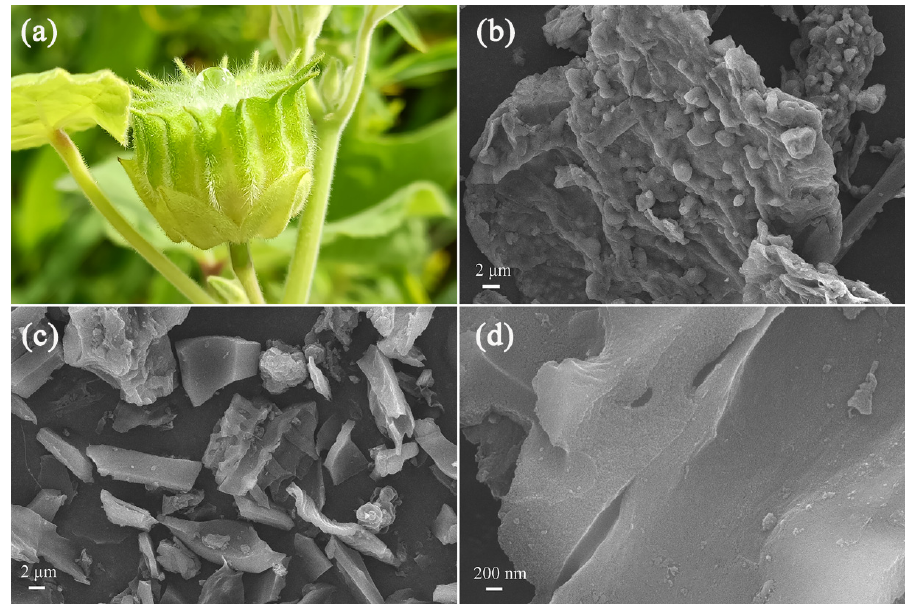
Figure 3. ( a ) The photograph of AC; the SEM images of ( b ) AC fragments and ( c , d ) PCAC. The results of the elemental analysis showed that the mass fractions of C, H, N, S, and O elements in PCAC were 86.04, 0.69, 0.17, 0.00, and 6.59, respectively. This indicates that the main component of PCAC was carbon. In the Raman pattern of PCAC (Figure 4a), there are two characteristic peaks at 1360 (D-band) and 1580 cm − 1 (G-band), respec- tively, which may be assigned to the disordered carbon and the crystalline carbon, respec- tively. The intensity ratio of I D to I G was 0.99. This demonstrates that PCAC contains both defective graphitic structures and graphitic layers [40].